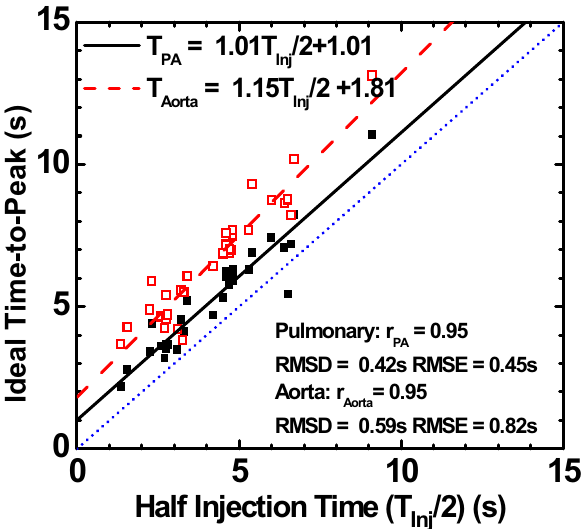
Figure 4. Time-to-peak delays in the pulmonary artery and descending aorta. Gamma-fit ideal time-to-peak delays were compared to the one-half injection time in all experimental animal data. Pulmonary arterial time- to-peak (black) and the aortic time-to-peak (red) are paralleled with different interceptions (dispersion factor). The blue dot line is the unity line. Gamma fit time-to-peak ( T PA , T A ) is defined as the time between the peak of the second derivative of the gamma fit and the true peak of the gamma fit, respectively. T Inj : contrast injection time; RMSE: root-mean-square-error; RMSD: root-mean-square-deviation; r: Pearson correlation coefficient.